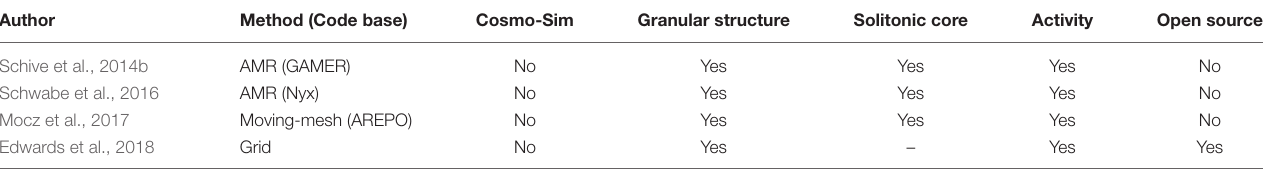
TABLE 2 | Summary of the Eulerain based simulation codes for FDM model (Schrödinger-Poisson